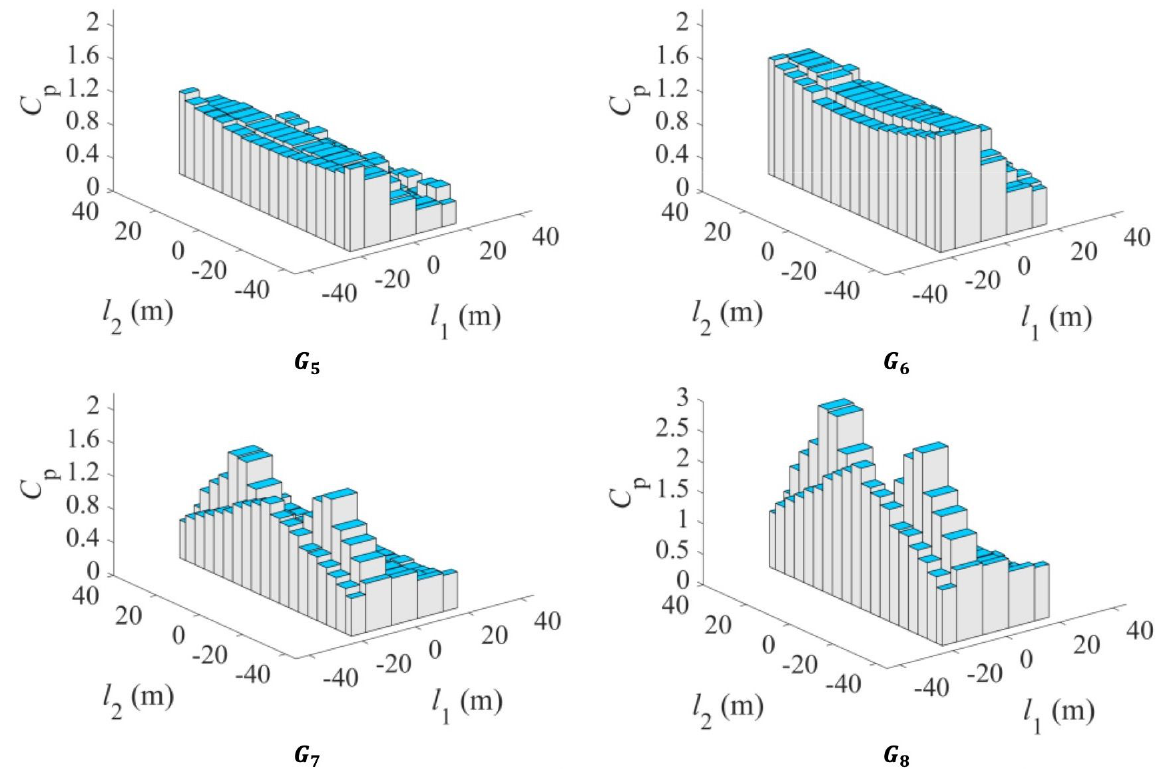
Figure 6: Mean pressure coeflcients of rectangular plan geometries with θ = 90 ∘ [16]